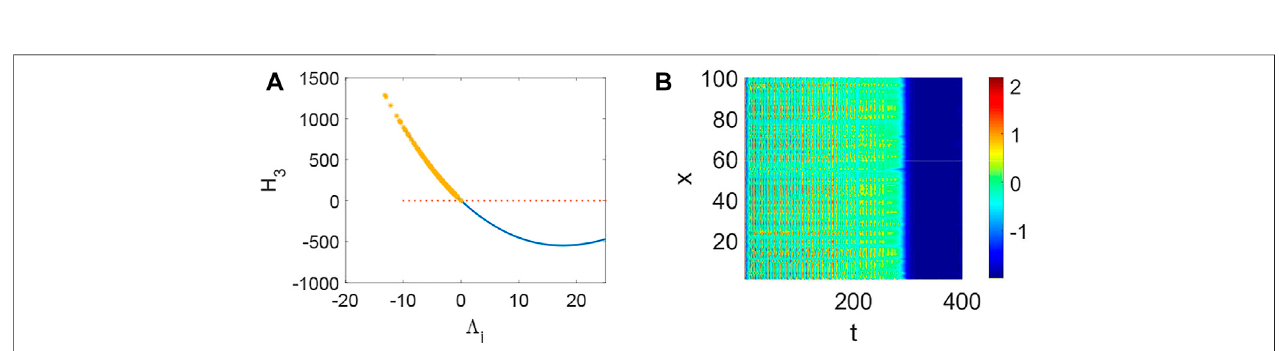
FIGURE2| Thestabilityofsystem(1)when p =0.05, τ =0. (A) Thedistributionofeigenvalues Λ i (labeledby*)when q =0. (B) Thecorrespondingpatternformation is stable in system (1) when no eigenvalue Λ i make H 3 < 0 hold.